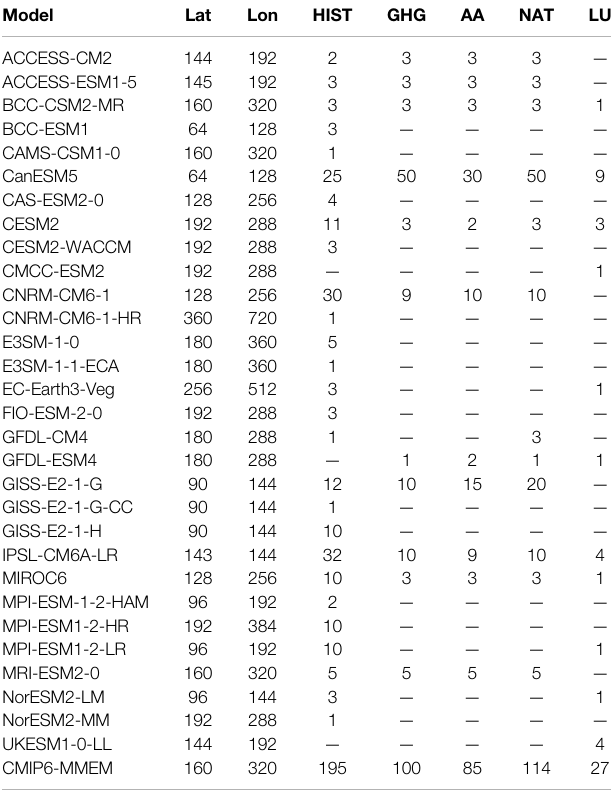
TABLE 1 | CMIP6 models ( fi rst column), latitude grid points (second column), longitude grid points (third column), and number of mrsos (moisture in the upper portion of the soil column) members (fourth and after column) in different experiments. HIST is all forcing simulation experiment — GHG, AA, NAT, and LU — is only considering greenhouse gases, anthropogenic aerosols, natural, and land use forcing experiment, respectively. Model